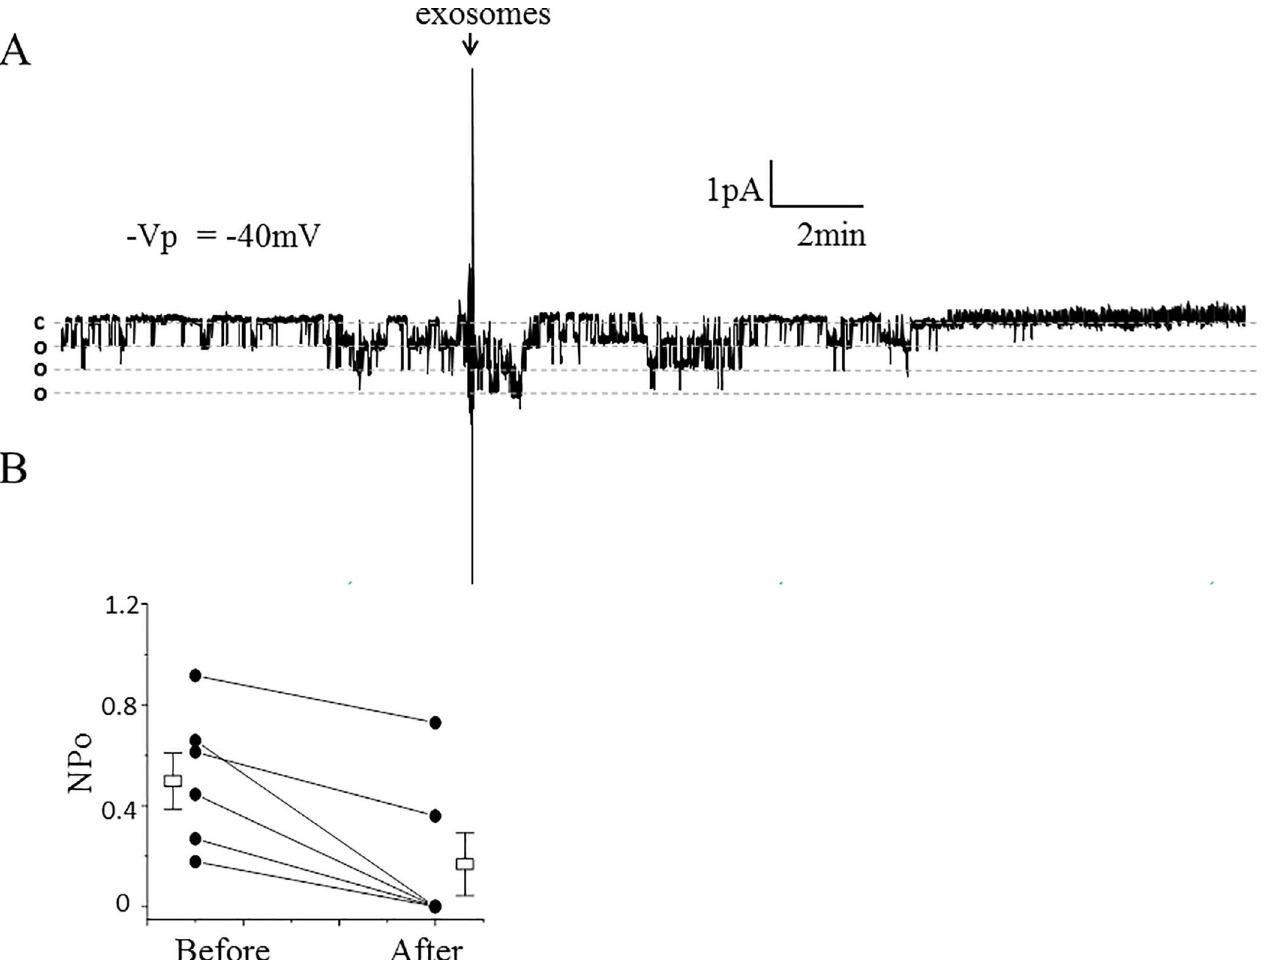
Fig 8. Effect of exosomes isolated from conditioned media on the apical side of LLC-PK1 cells on ENaC activity in Xenopus 2F3 cells. (A): representative single-channel recording using the cell-attached configuration shows a decrease in ENaC activity after applicationof apical plasma membrane LLC-PK1 exosomes to the apical side of Xenopus 2F3 cells. The dashed lines denote open and closed levels (o, open and c, closed). The number of current levels represents the number of channelsin the patch. The arrow indicates the time point at which the exosomes were appliedto the cells. (B): summary line graph showingthe open probability( P o ) of ENaC decreasedwithin 10 minutes of applyingexosomes to the apical surface of Xenopus 2F3 cells. Each point represents the mean ± s.e. and the data shown are from 6 separate patches (N = 6); P =